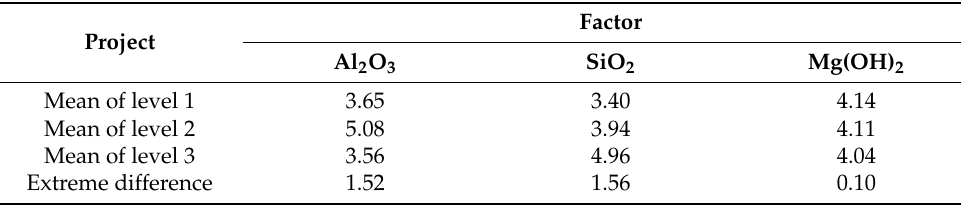
Table 3. Mean and extreme difference analysis of tensile strength for each factor (MPa).